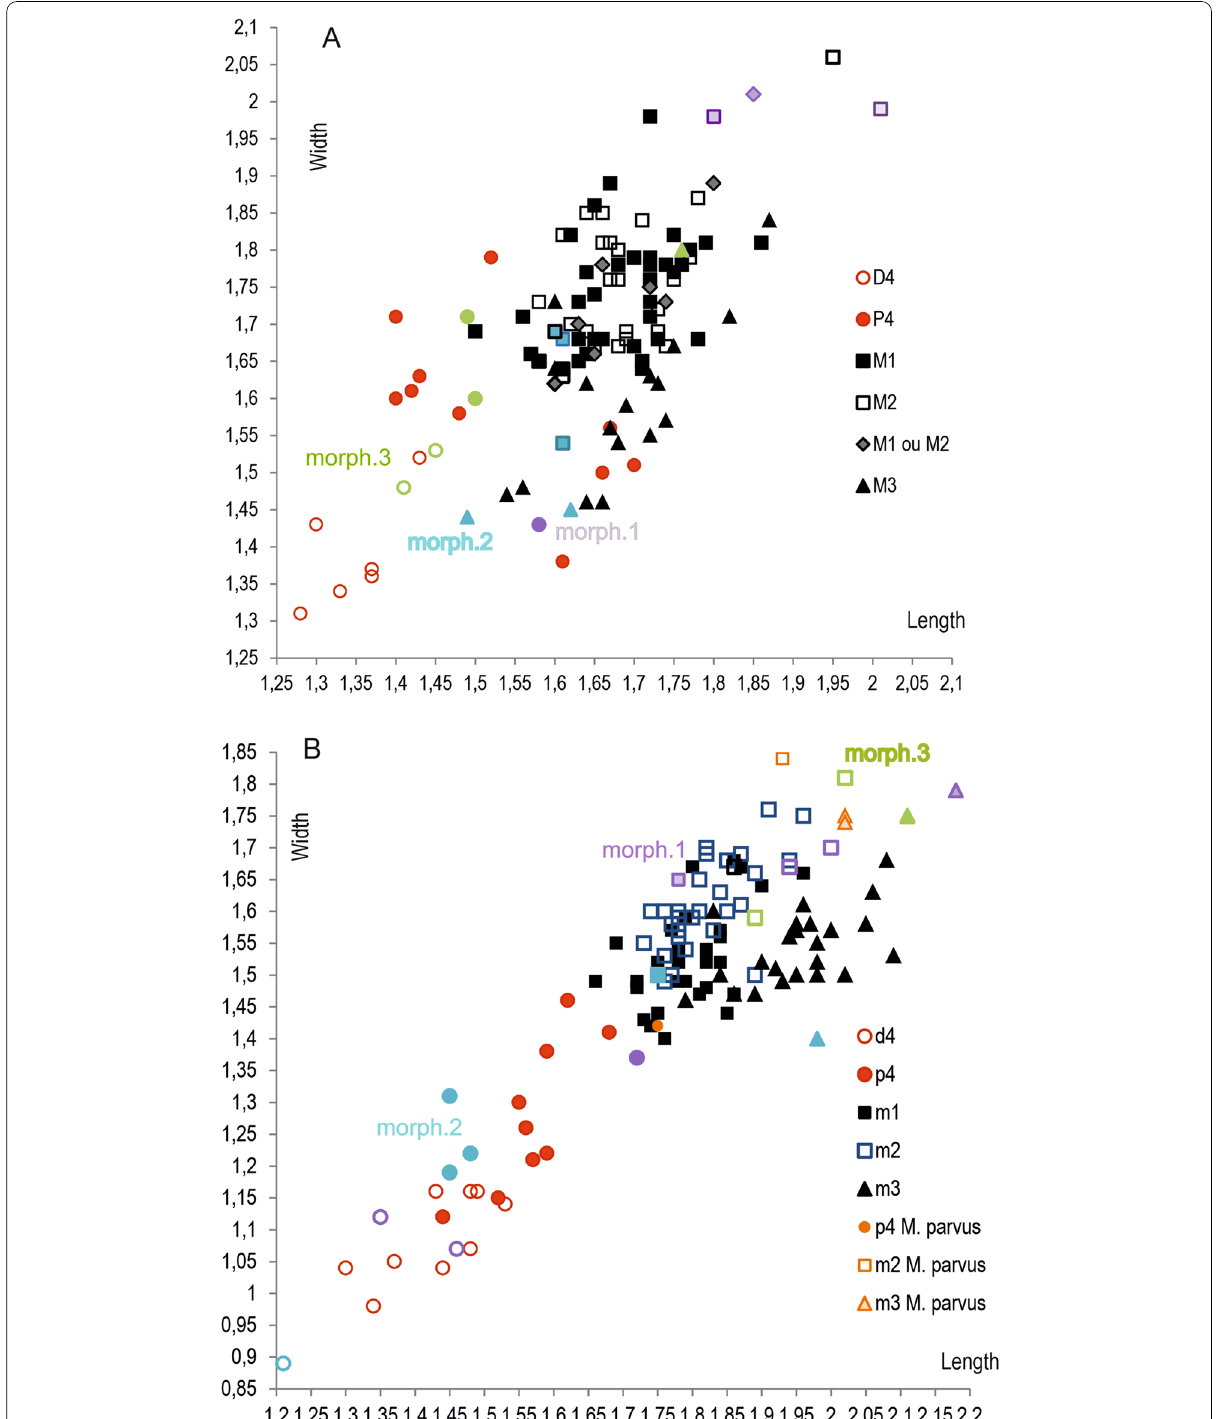
Fig. 27 Bivariate graph of the size (width/length) of the upper ( A ) and lower (B) teeth of ? Protadelomys alsaticus Hartenberger, 1969 from Bouxwiller (Bas‑Rhin) (dp4/DP4 and p4/P4: red marks; upper and lower molars: black marks). From Bouxwiller, a few teeth are identified as ?P. cf. alsaticus sp. indet 1 (purple marks), sp. indet 2 (turquoise blue marks) and sp. indet 3 (green marks). On B , four teeth (orange marks) are Masillamys parvus from Messel